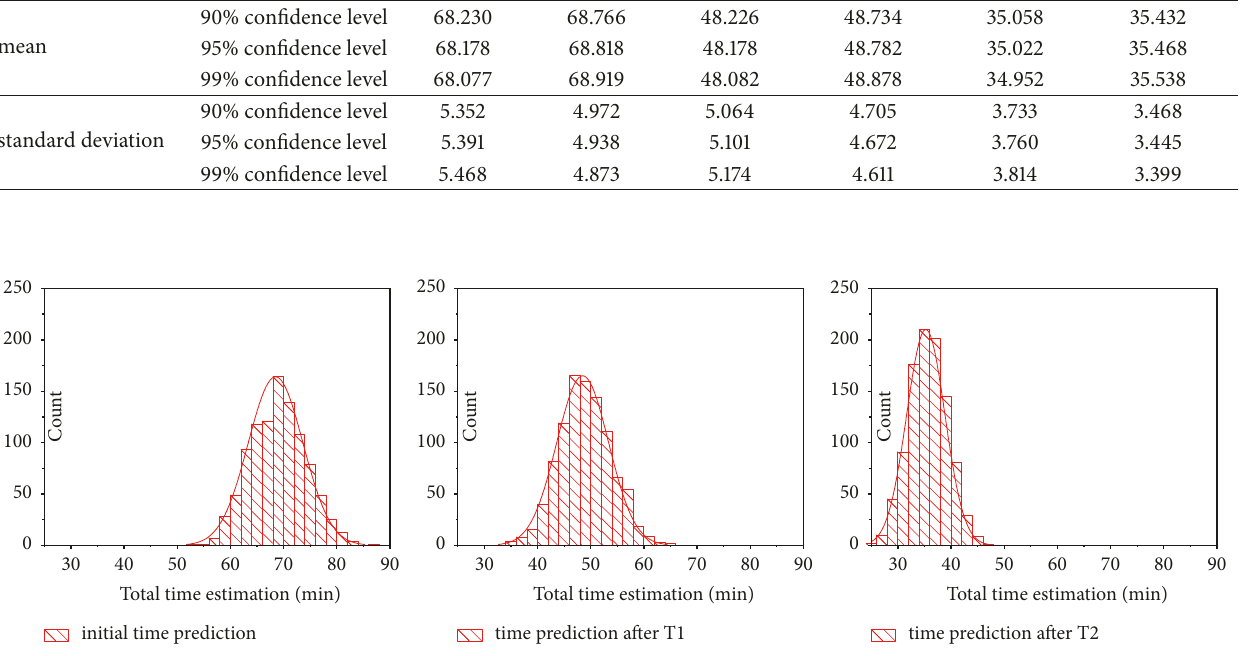
Figure 5: Prediction of the ending time of the emergency response.